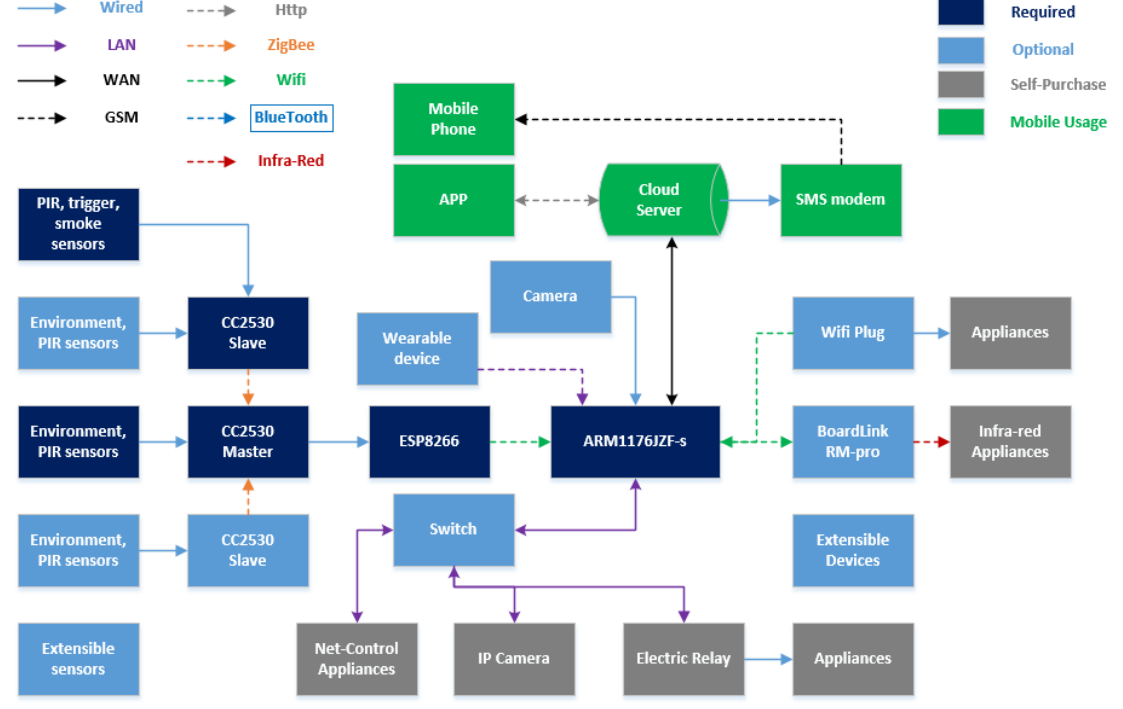
Figure 11. Architecture and module connections of sensing home.